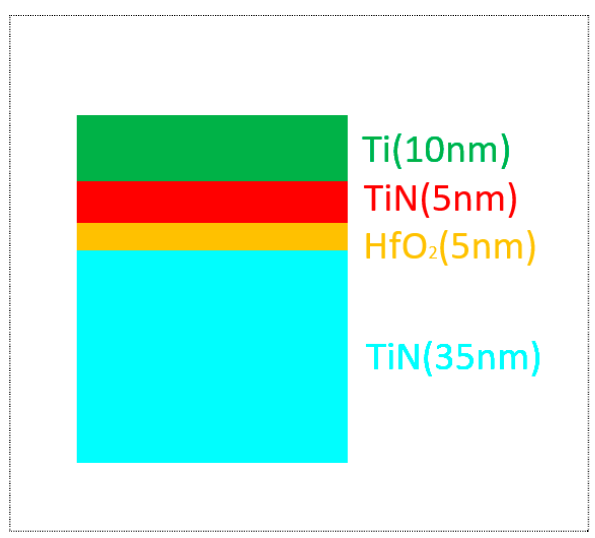
Figure 9. The RRAM made of a thin HfO 2 .